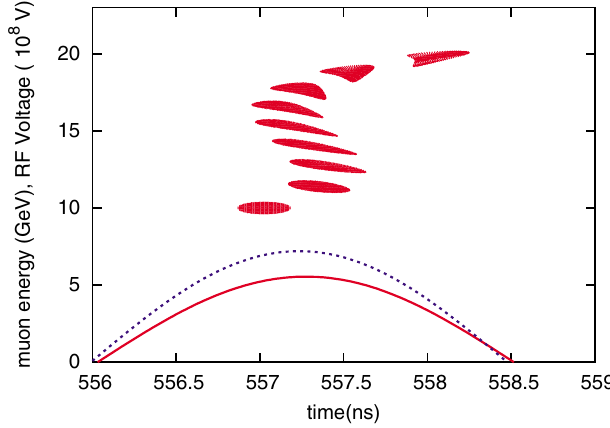
FIG. 22. (Color) Initial (dash) and final (full) rf voltage, and evolution of the bunch on turns 0 ; 2 ; . . . 16 , for L (cid:1) 328 m . C 0